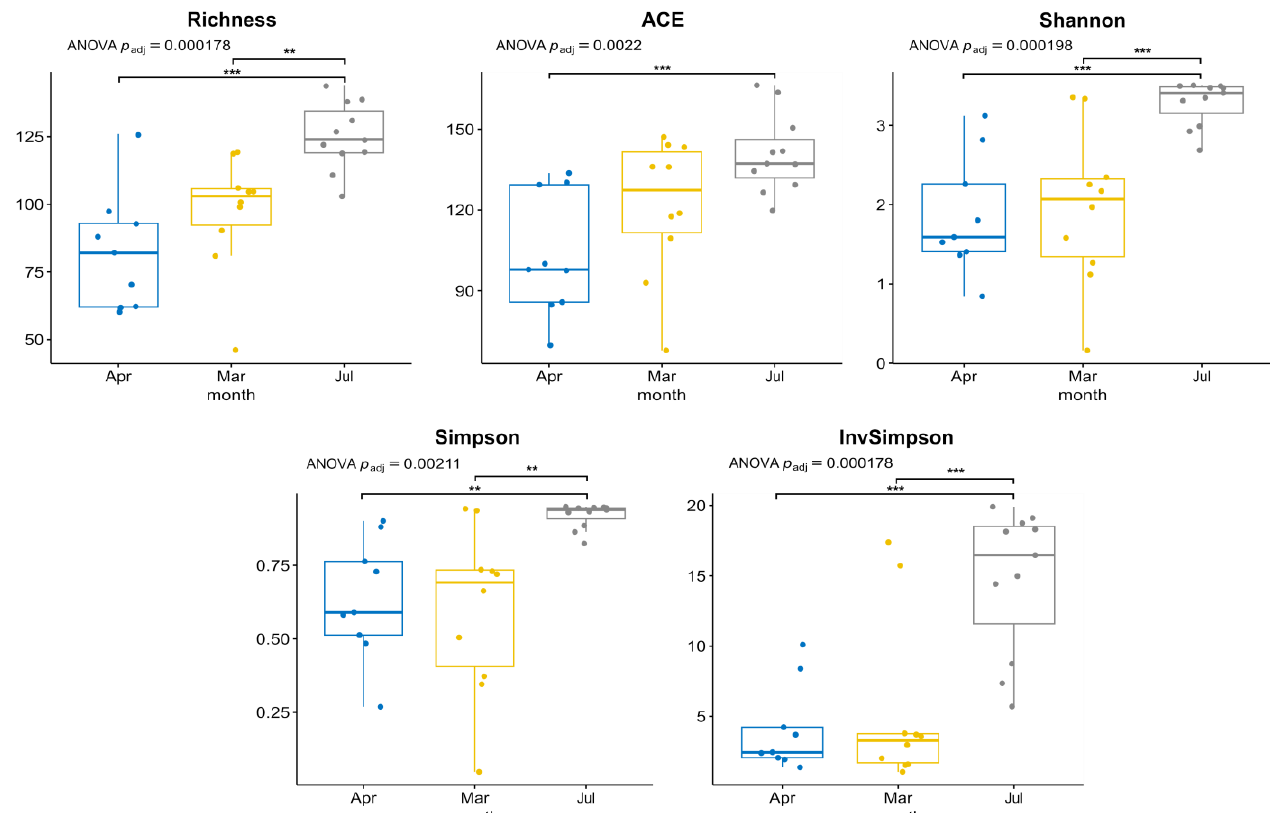
Figure 3. Alpha diversity indices in microeukaryotic communities. Significance code of Tukey’s post hoc tests: *** ≤ 0.001; 0.001 ≤ ** ≤ 0.01.